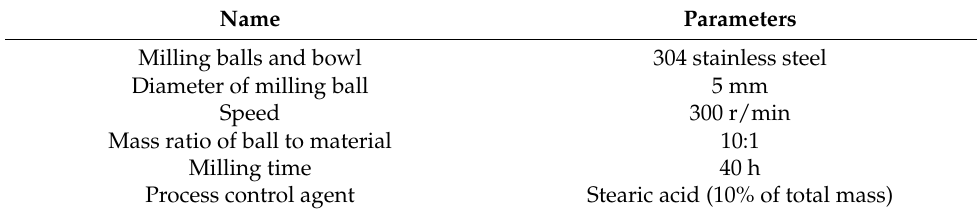
Table 1. Ball milling parameters of 3Ti + B 4 C → 2TiB 2 +